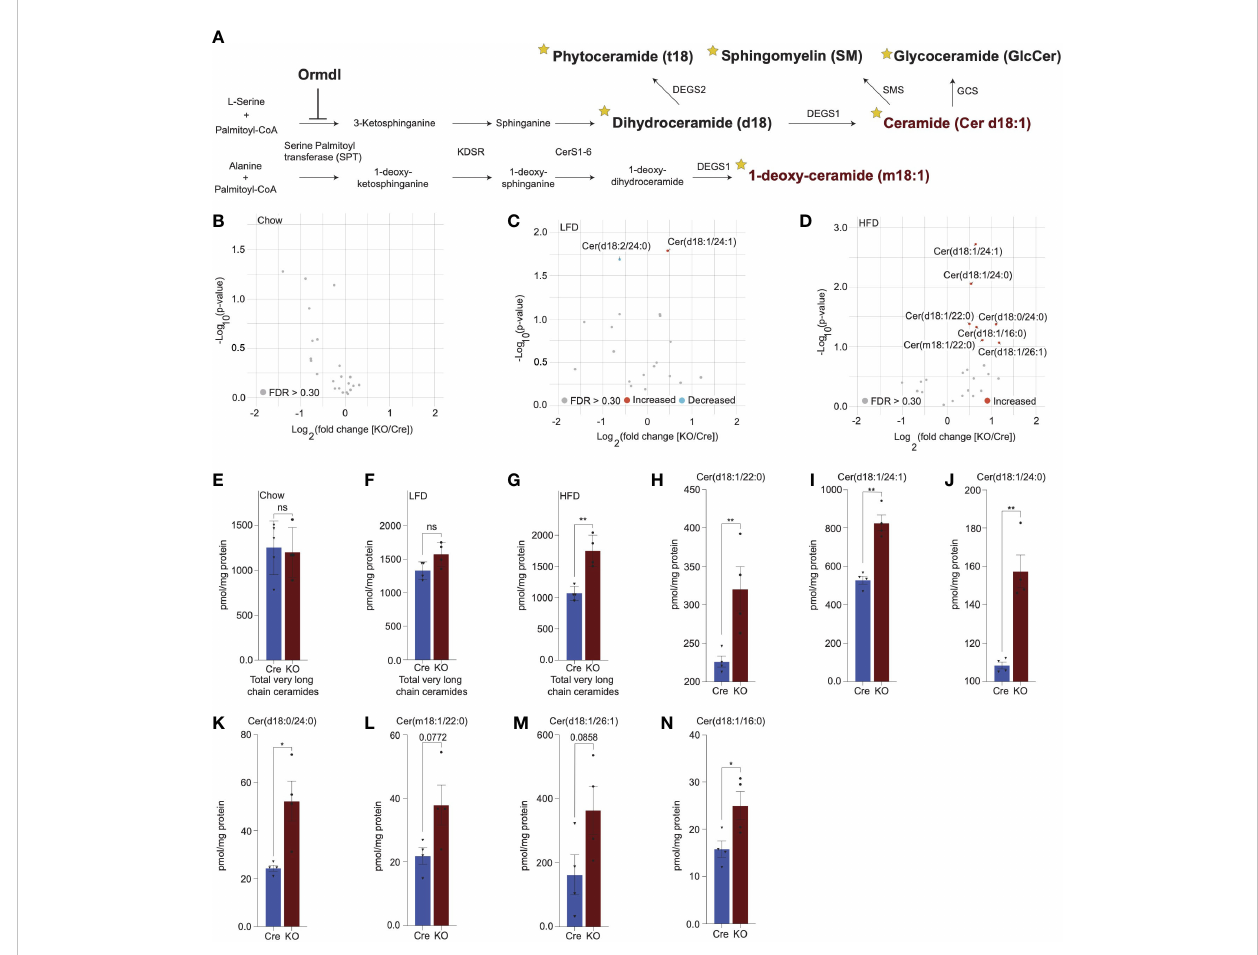
FIGURE 3 Lipidomics analysis reveals signi fi cant upregulation of very long chain ceramide species in islets of high fat diet-fed Ormdl3 b -/- mice. (A) Schematic illustration of de novo sphingolipid biosynthetic pathway (stars denote lipid classes measured). (B) Volcano plot of fold change in lipid species between 10-week-old chow-fed Cre and KO mice. (C) Volcano plot offold change in lipid species between LFD-fed Cre and KO mice after 24-weeks-on-diet (30 weeks of age). (D) Volcano plot offold change in lipid species between HFD-fed Cre and KO mice after 24-weeks-on-diet (30 weeks of age). (E-G) pmol total very long chain ceramide species (C22-26) normalized to total protein content (mg) in (Welch ’ s t-test) (E) 10-week-old chow-fed Cre (n=5) and KO (n=4) mice. (F) LFD-fed Cre (n=4) and KO (n=4) after 24-weeks-on-diet (30 weeks of age). (G) HFD-fed Cre (n=4) and KO (n=4) mice after 24-weeks-on-diet (30 weeks of age). (H-N) pmol ceramide species for HFD-fed mice normalized to total protein content (mg) for (Welch ’ s t-test) (H) Cer(d18:1/22:0), (I) Cer(d18:1/24:1), (J) Cer(d18:1/24:0), (K) Cer(d18:0/24:0), (L) Cer(m18:1/22:0), (M) Cer(d18:1/26:1), and (N) Cer(d18:1/16:0). Data are presented as means ± SEM. Unpaired t- test with Welch correction (*p<0.05, **p<0.01) is applied where indicated. KDSR, 3-keto-dihydrosphingosine reductase; CerS1-6, Ceramide synthase 1-6; DEGS1, D 4-dihydroceramide desaturase 1; DEGS2, D 4-dihydroceramide desaturase 2; GCS, glycoceramide synthase; SMS, sphingomyelin synthase. FDR, false discovery rate; FDR q >.3, grey dots; FDR q <.3, red dots represent upregulated species and blue dots represent downregulated species; Cre, mouse expressing Ins1 tm1.1(cre)Thor/J with wild type Ormdl3 alleles; KO, Ormdl3 b -/- homozygous knockout; ns, not signi fi